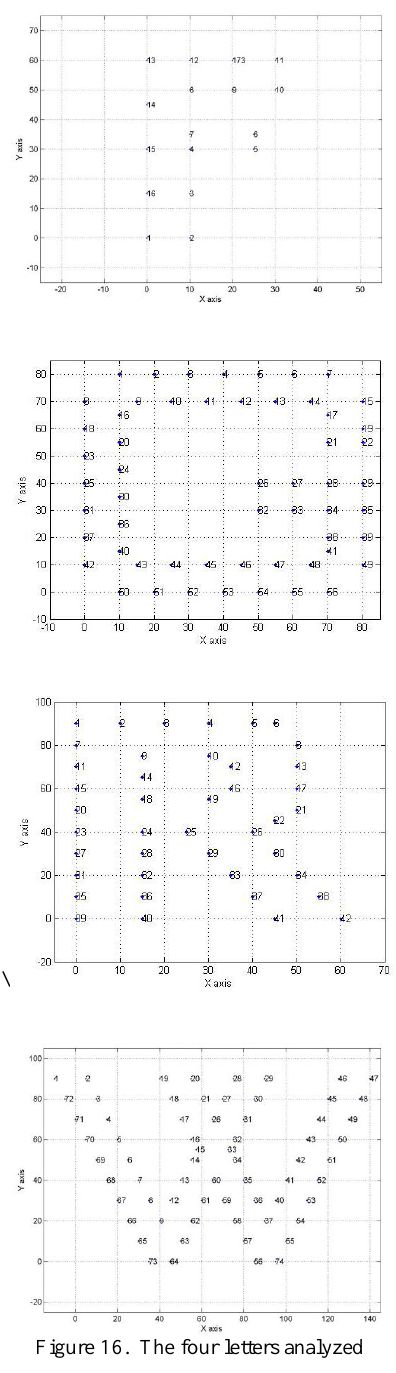
Figure 15. Distinction between sowns